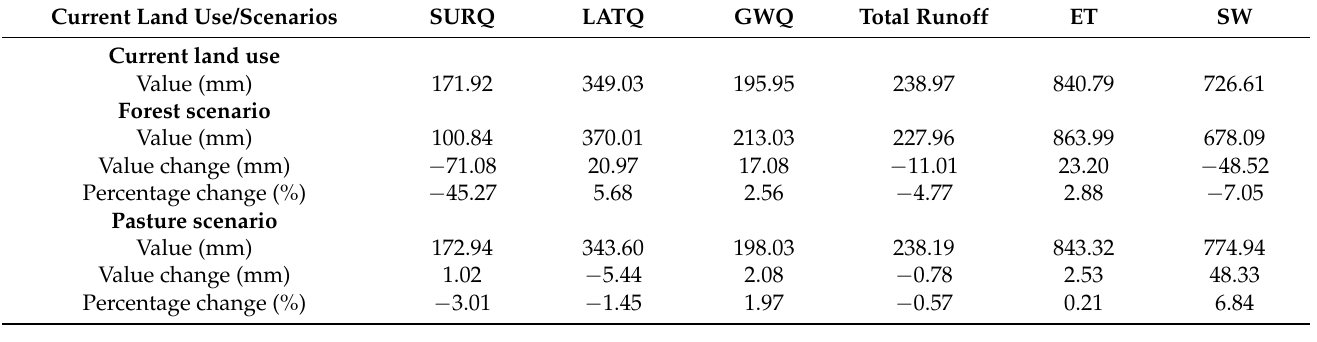
Table 6. The average annual values of current land use and the average annual values change and percentage change of both scenarios (Forest and Pasture) for the components: surface runoff (SURQ), lateral runoff (LATQ), groundwater (GWQ), total runoff, evapotranspiration (ET), and soil water (SW). The data are between 1982 and 2013 of the Uberaba River basin.